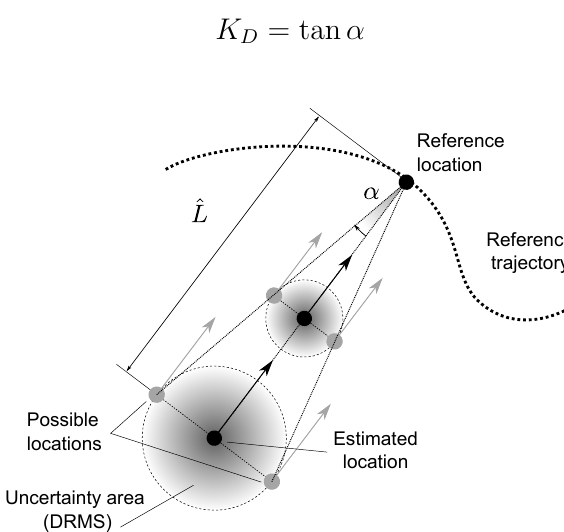
Figure 3. Diagram explaining the relation Equation (26) between the distance to the reference location and the size of the uncertainty region.